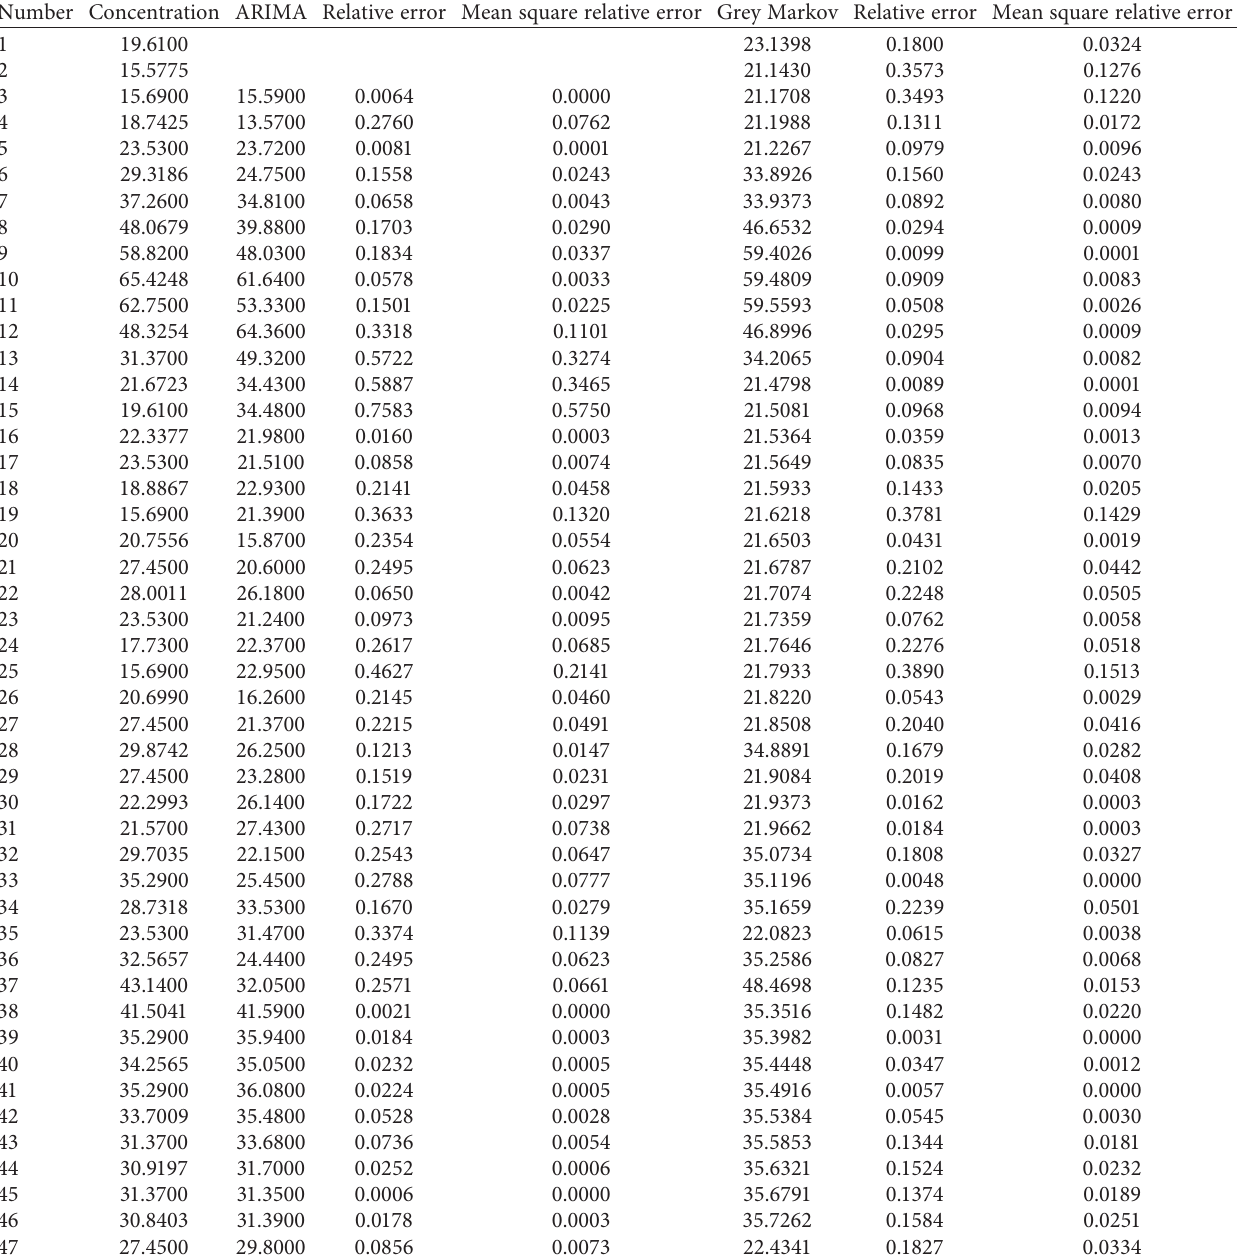
Table 6: Comparison between ARIMA model and grey Markov